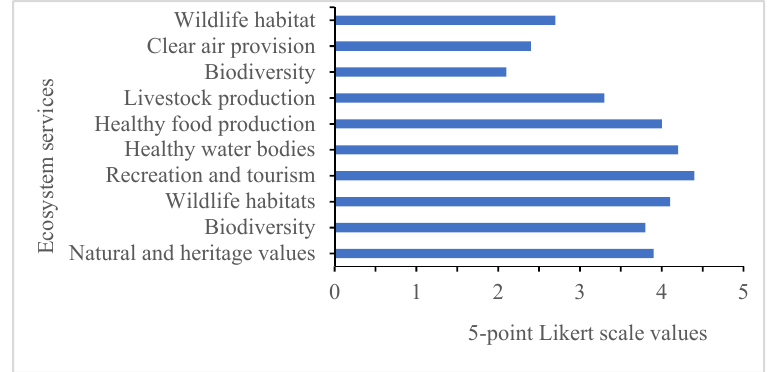
Figure 3. Ten most important ecosystem services.